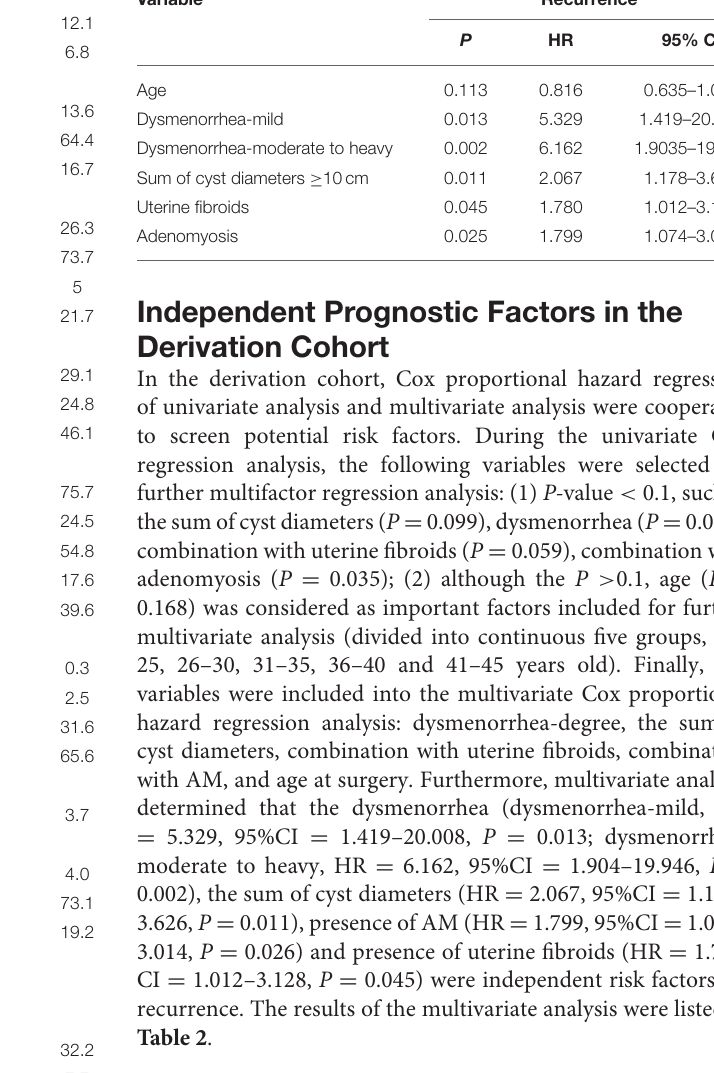
recurrence. The results of the multivariate analysis were listed in